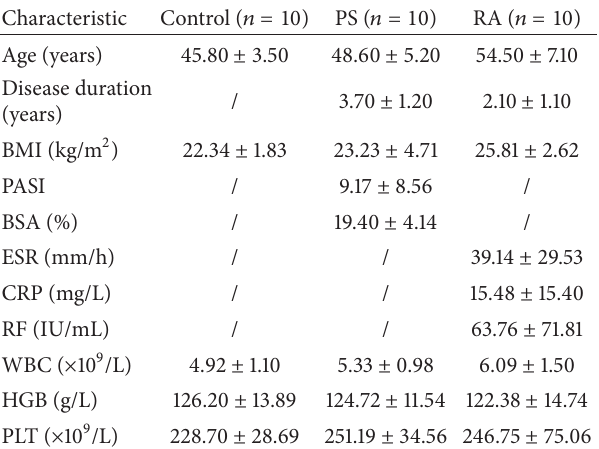
Table 1: Characteristics of the enrolled subjects for the three